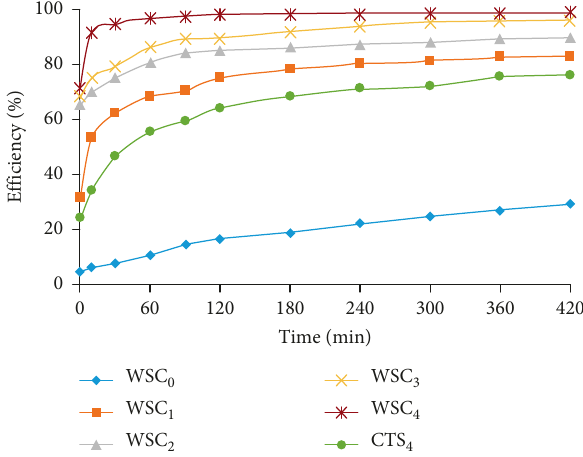
Figure 6: Efficiency of antioxidant activity of WSC and CTS reaction